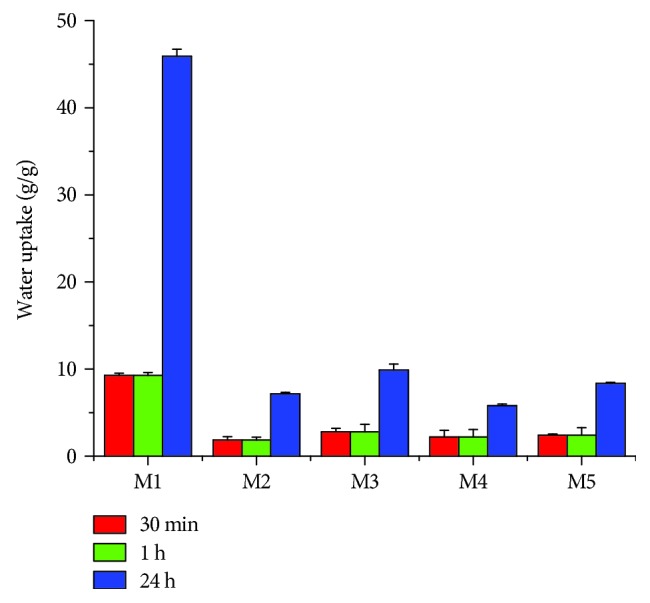
Water uptake of multiparticulate systems.